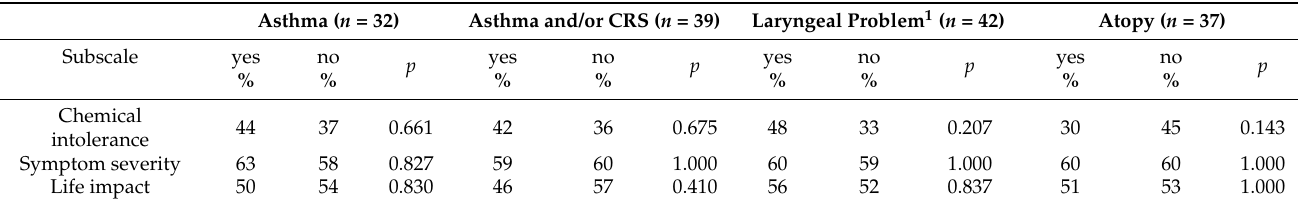
Table 2. Proportions of study patients with different illnesses or findings reporting high scores in chemical intolerance, symptom severity, and life impact subscales (CRS = chronic rhinosinusitis).